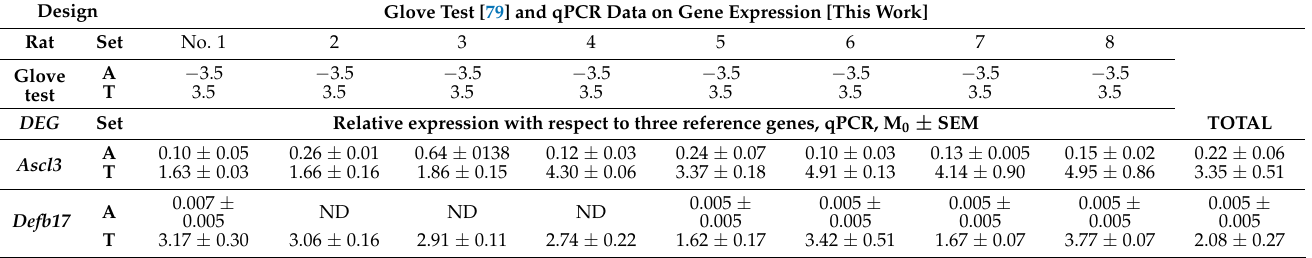
Table 3. qPCR data on a selection of DEGs from the PAG of 16 additional unrelated adult male rats, eight tame and eight aggressive.